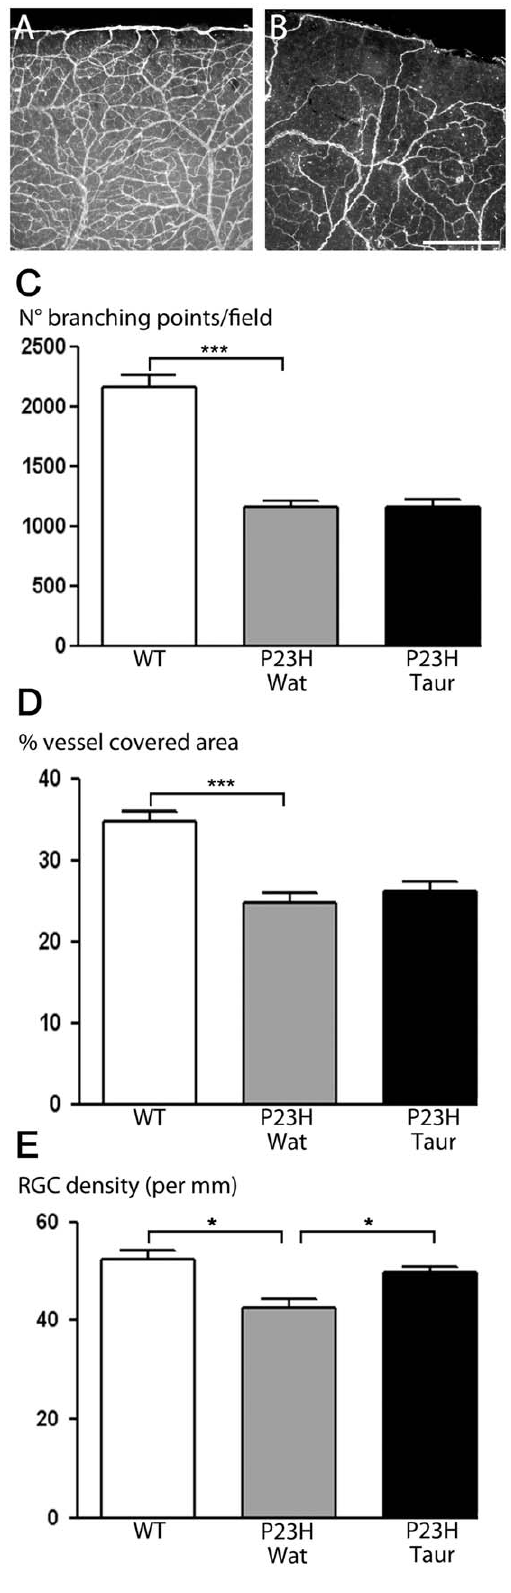
Figure 6. Taurine prevents RGC degeneration in P23H rats with blood vessel atrophy. A, B) Representative pictures showing the lectin staining of blood vessels at the periphery of flat-mounted retinae from a one-year old Sprague-Dawley rat (A) and a one-year